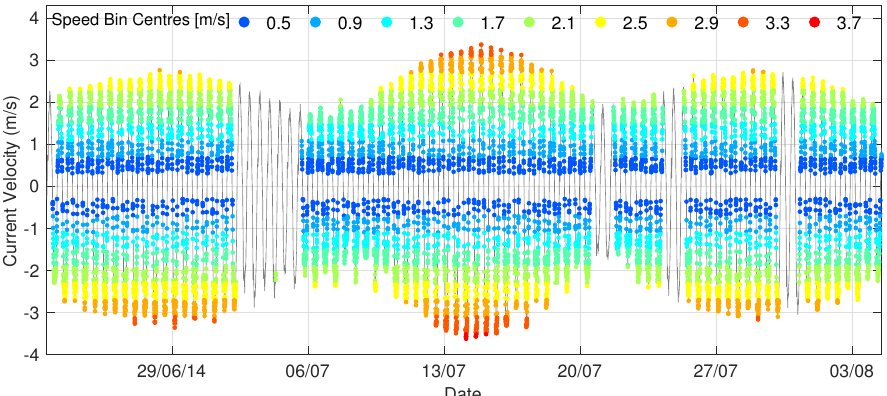
Figure 7. Time series of velocity data (June–July 2014) acquired by an upstream D-ADP. Filtered data are shown segregated by speed bin-centres (graduated colours). The grey line shows all acquired data: gaps represent excluded data where significant wave height, H m 0 , exceeds the 0.8-m